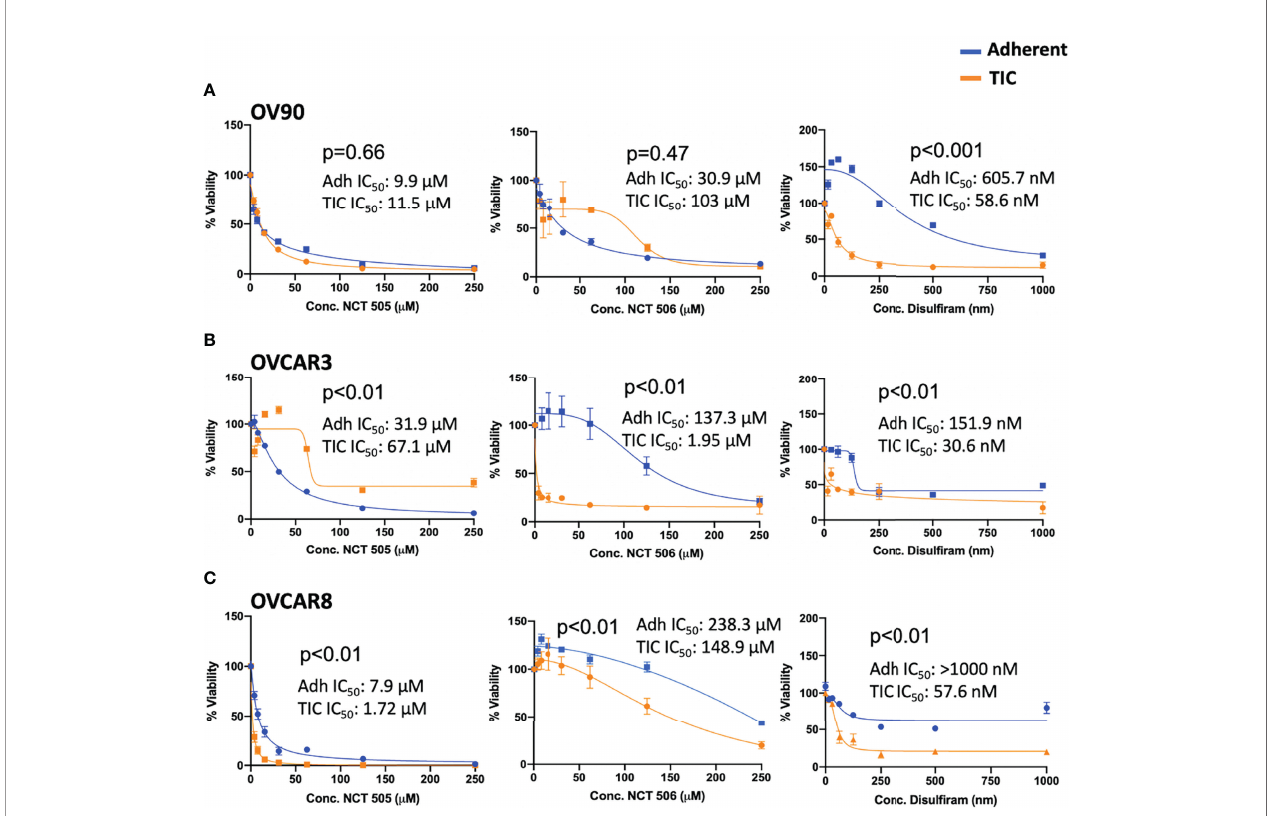
FIGURE 3 | Viability of (A) OV90, (B) OVCAR3, and (C) OVCAR8 cells in adherent (blue) and TIC growth conditions (orange), treated with NCT-505, NCT-506 or Disul fi ram. Graphs represent mean and SEM.